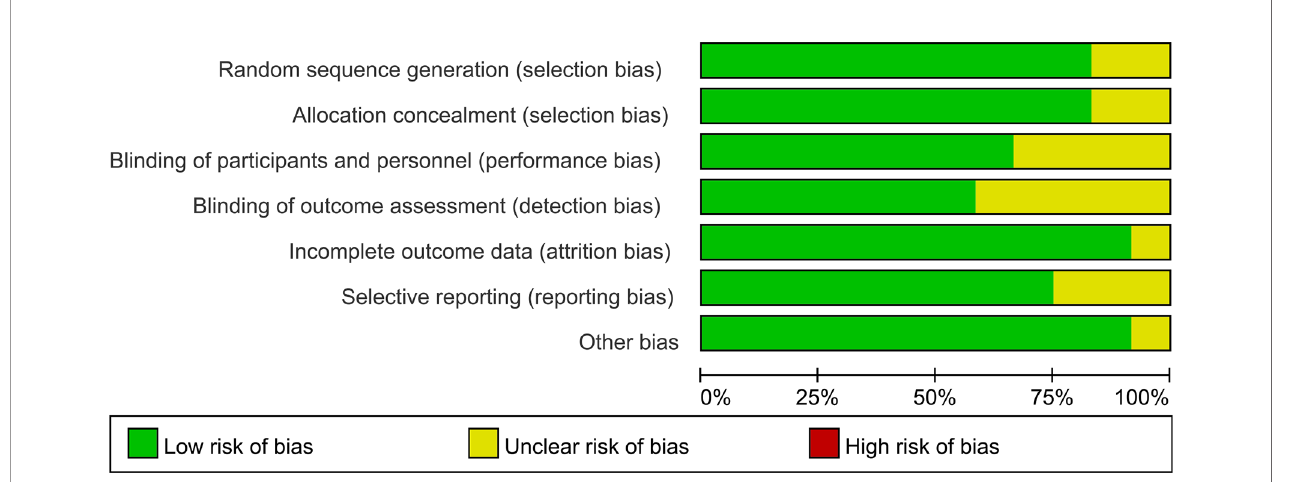
FIGURE 2 | Risk of bias assessment across included